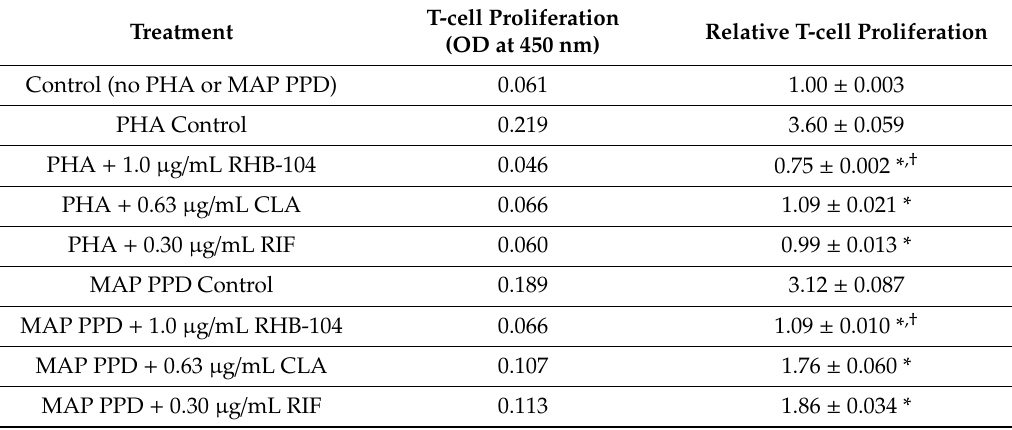
Table 4. T-cell proliferation following treatment with MAP purified protein derivative (PPD) or phytohemagglutinin (PHA) and RHB-104, and its major components.